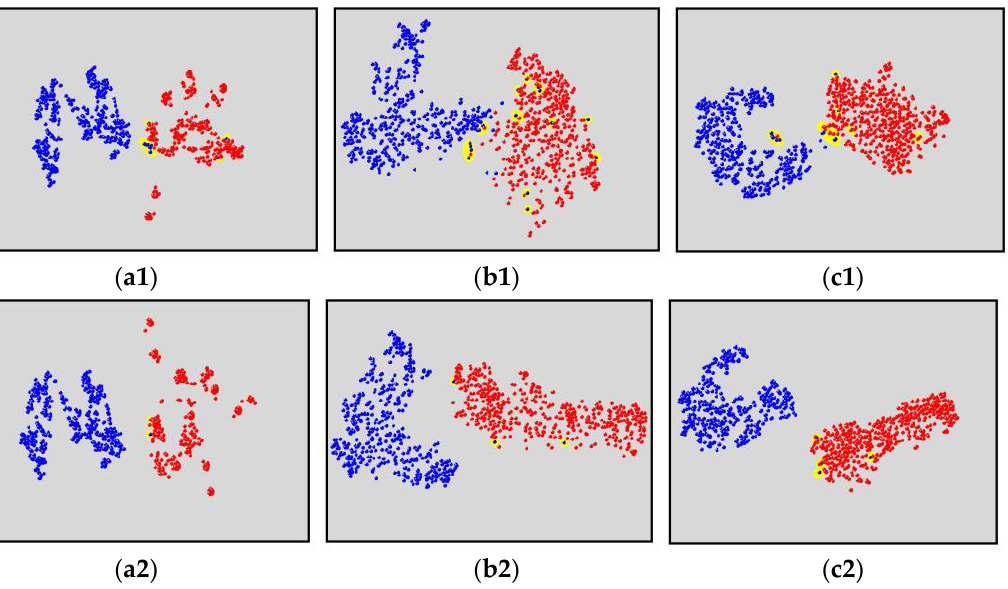
Figure 7. Comparison of the feature enhancement results. The blue dots in the image indicate the normal signal feature vectors, the red dots indicate the abnormal signal feature vectors, and the yellow areas indicate the feature vector confusion locations. The sample size of both the normal and abnormal signals in the graph is 500. ( a1 ) The distribution of the local similarity feature vectors in the embedding space of the two echoes signal and the anomalous signal before the feature enhance- ment. ( a2 ) The distribution of the local similarity feature vectors in the embedding space of the two echoes signal and the anomalous signal after the feature enhancement. ( b1 ) The distribution of the local similarity feature vectors in the embedding space of the three echoes signal and the anomalous signal before the feature enhancement. ( b2 ) The distribution of the local similarity feature vectors in the embedding space of the three echoes signal and the anomalous signal after the feature enhance- ment. ( c1 ) The distribution of the local similarity feature vectors in the embedding space of the four echoes signal and the anomalous signal before the feature enhancement. ( c2 ) The distribution of the local similarity feature vectors in the embedding space of the four echoes signal and the anomalous signal after the feature enhancement.